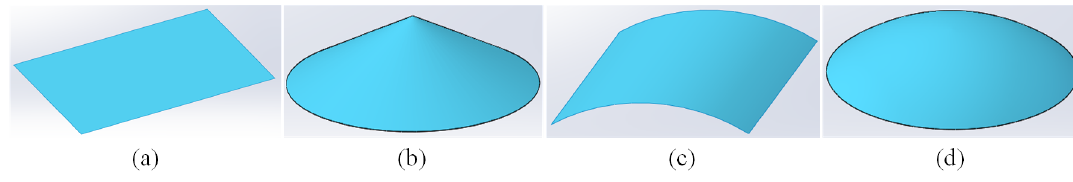
Figure 3. An illustration of typical geometric primitives that may result in false positives yielded by Z clustering. ( a ) A sloped plane whose gradient exceeds the threshold. ( b ) A cone. ( c ) The upper surface of a tube. ( d ) The upper surface of a